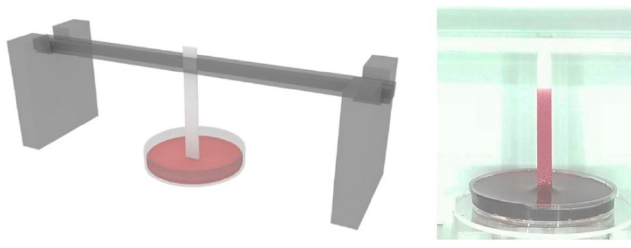
Figure 4. Schematic diagram of experiment setup.